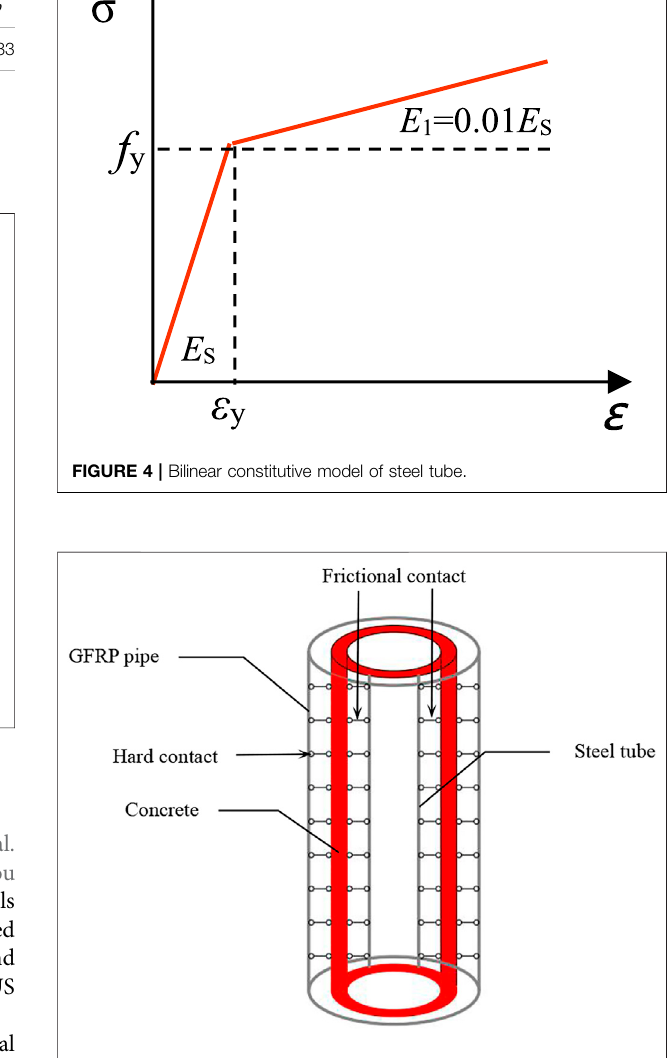
FIGURE 5 | Material contact relationship of composite long